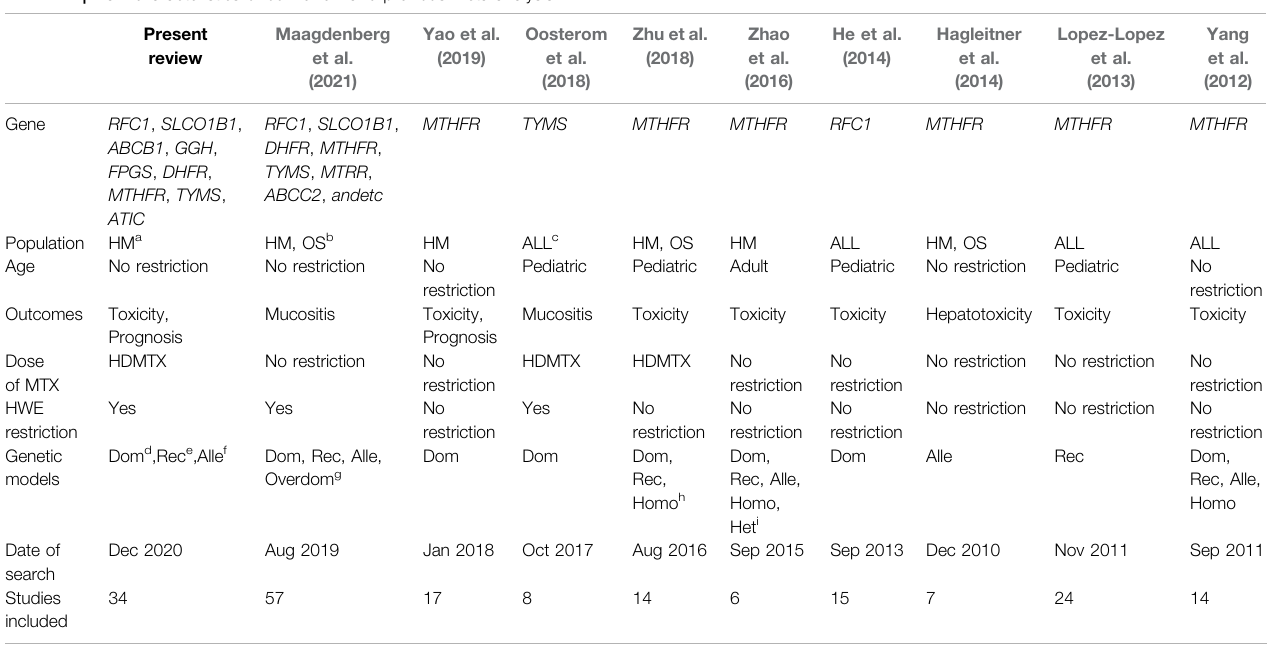
TABLE 4 | Main characteristics of our review and previous